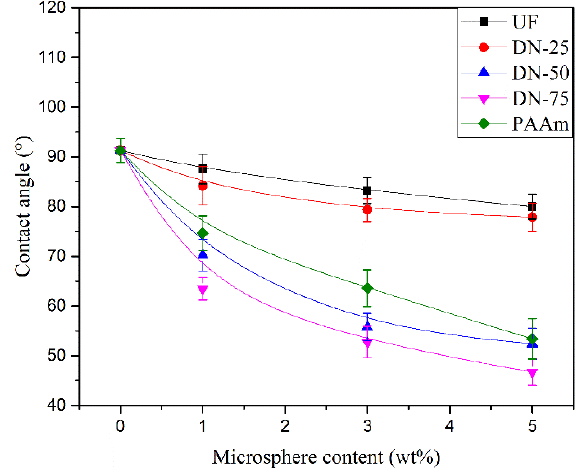
Fig. 5 Effects of type and content of microsphere on the wettability of